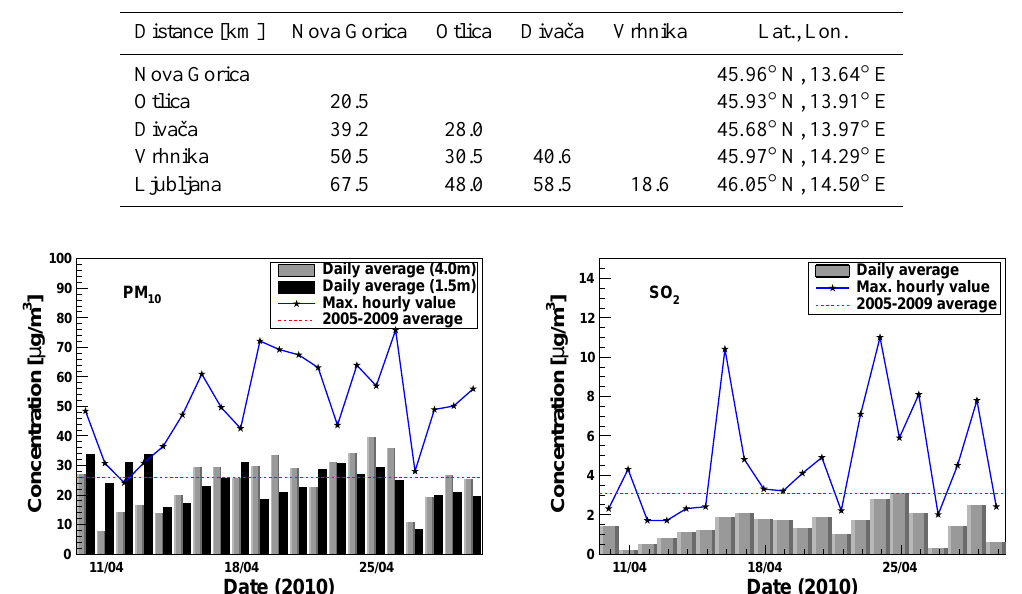
Table 1. Distance between measurement sites used in the campaign.